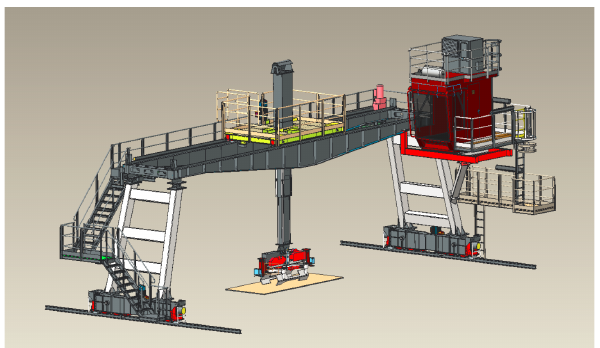
Figure 4: The Gantry Crane - courtesy of MHWirth AS